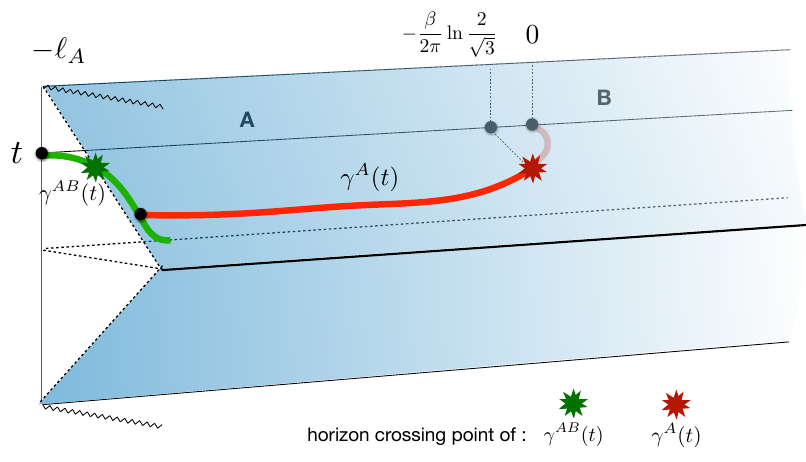
Figure 23 . Decomposing (cid:13) A ( t ) into two parts: a part outside the horizon (transparent red); a part behind the horizon (solid